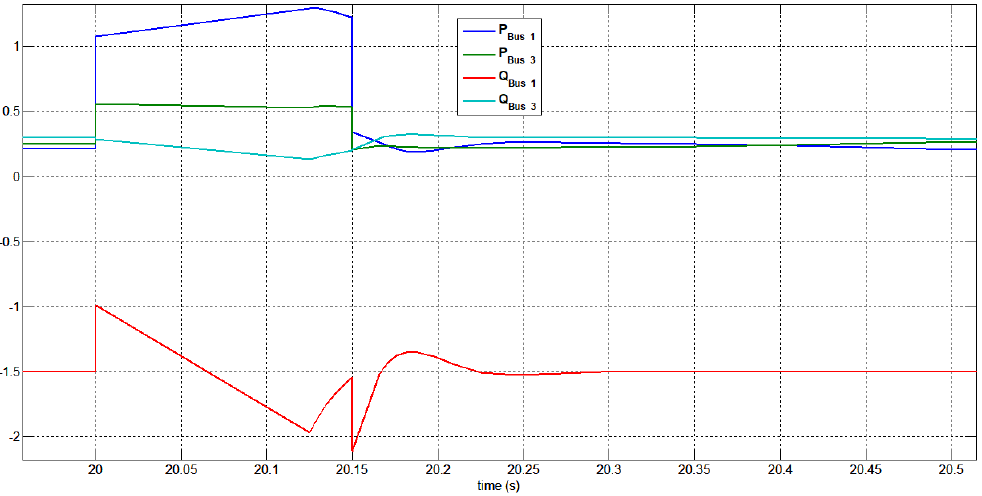
Figure 46. Generated active and reactive power at buses 1 and 3 under a three-phase short circuit at bus 15 with STATCOM.